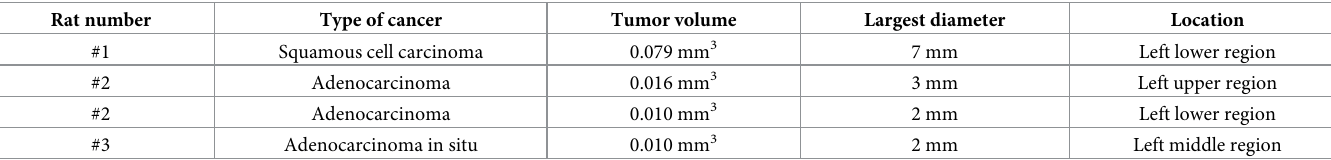
Table 1. The histopathologic characteristics of lung carcinomas 52 weeks after PHMG exposure. Rat